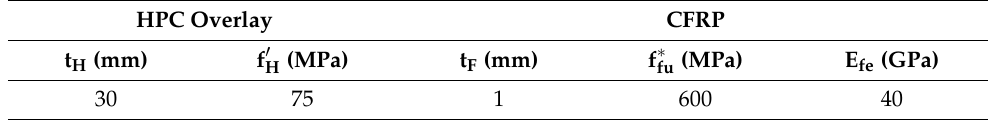
Table 5. Initial analyses of the retrofit system and reference slab.